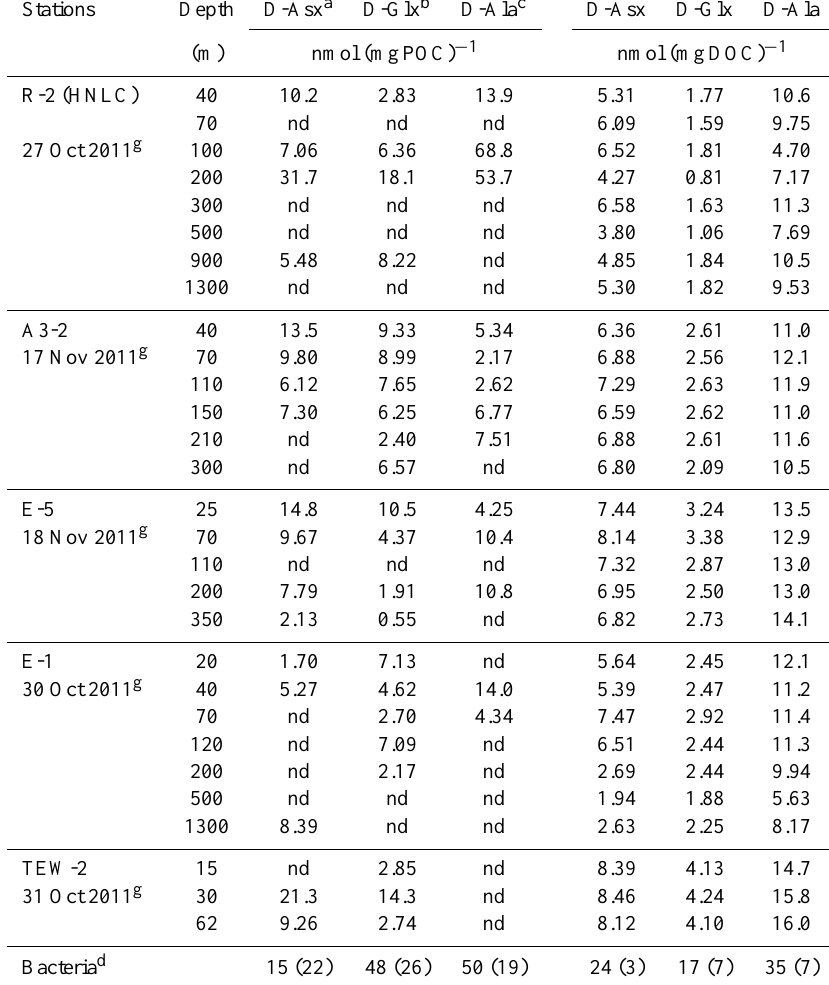
Table 2. Yields of D-AA in particulate and dissolved fractions along with average yields measured in cultured bacteria and bacterial DOM.